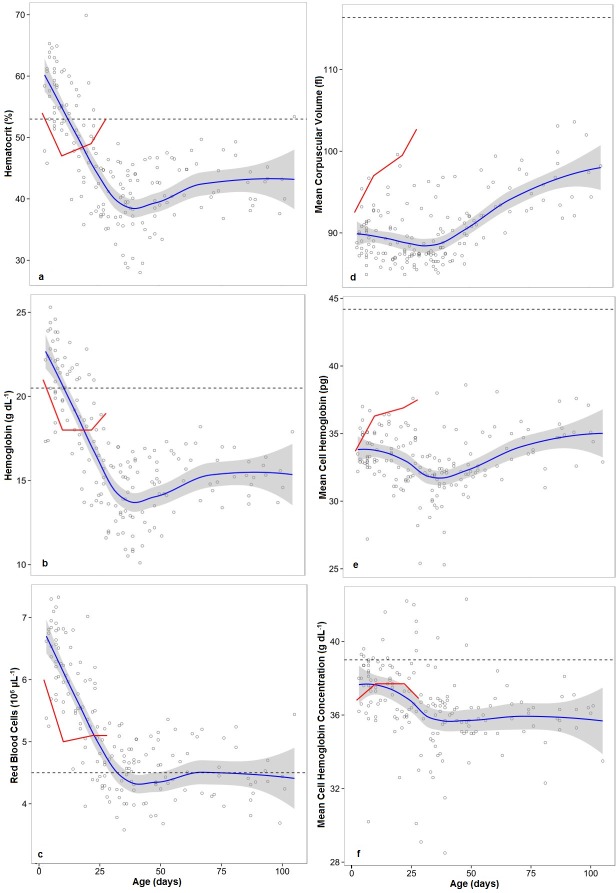
Effects of Age on Standard Blood Parameters in Rehabilitating Harbor Seal Pups.Effects of age on a. Hematocrit, b. Hemoglobin, c. Red Blood Cell Count, d. Mean Corpuscular Volume, e. Mean Corpuscular Hemoglobin and f. Mean Corpuscular Hemoglobin Concentration in rehabilitating harbor seal pups. The solid blue line represents the LOESS smoothing of the data from this study with a shaded area representing the 95% confidence interval. Each data point represents an individual blood sample (n = 173), from different pups (n = 21) in this study. The solid red line represents average data from wild nursing harbor seal pups from the literature [19], and the horizontal dashed line represents the average wild adult values from the literature [19].